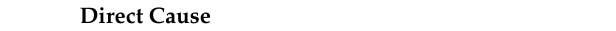
Table 2. Tunnel construction accident types and